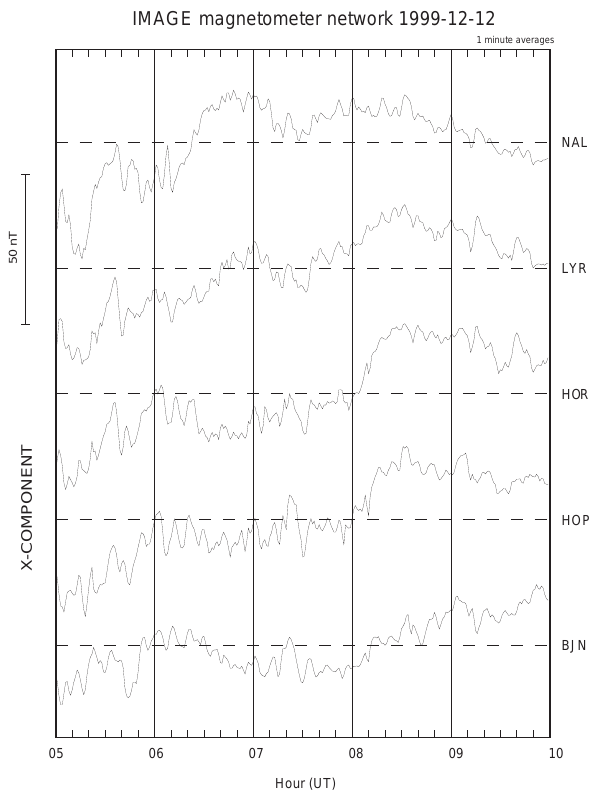
Figure 23 Fig. 23. X component magnetic deflections from the Svalbard IM- AGE stations, spanning the latitude range from 76 ◦ MLAT (NAL) to 71 ◦ MLAT (BJN). The interval shown is 05:00–10:00 UT on 12 De- cember 1999.